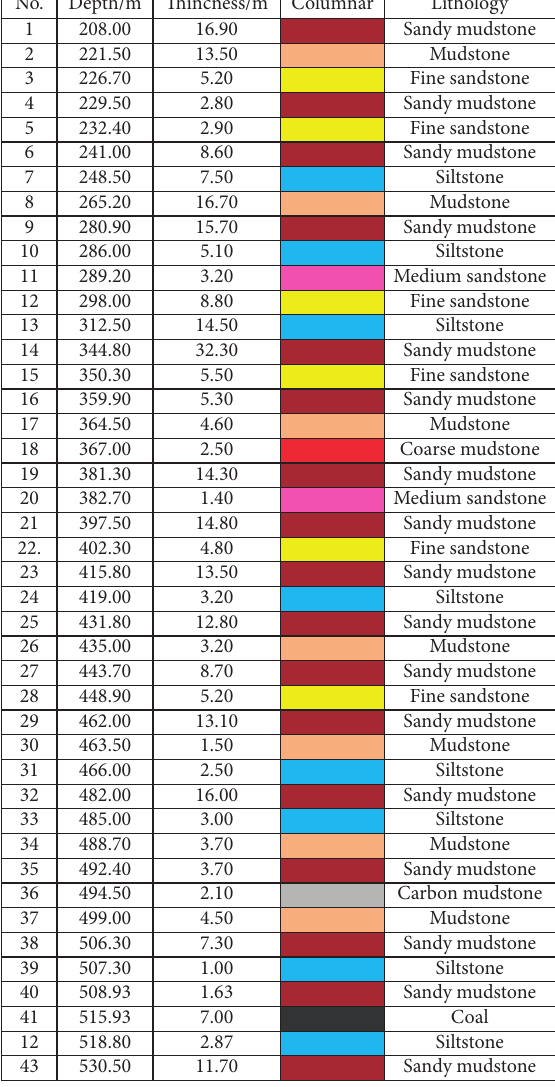
expand. The main bed separation in the middle part is most part of the lower bed separation is closed while the upper bed separation develops to its maximum (2.93 m), shown in Figure 8. With the advancing of the LTCC face, the upper bed separation begins to close, and it is totally closed when the LTCC face advances 335 m. In this process, the lower bed separation continues to develop along the longwall face advancing, and a new bed separation is generated. The distribution characteristic of the bed sep- aration is obtained through the CDEM simulation of the rapture and settlement of the overburden of the 4203 LTCC panel. It can be seen from Figure 7: the lower KS is an important bearing structure which controls the movement of the lower strata. The upper KS is an ultimate bearing structure controlling the movement of the upper strata and the surface subsidence.